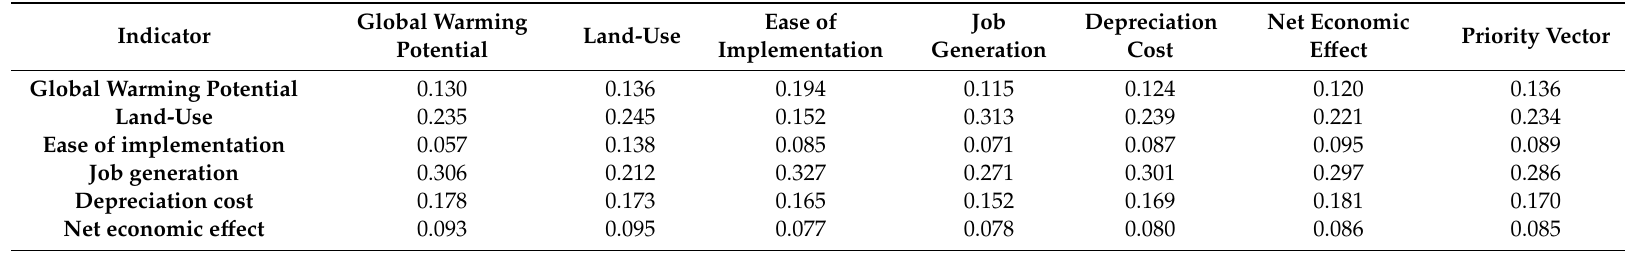
Table 7. Evaluation criteria comparison matrix and priority